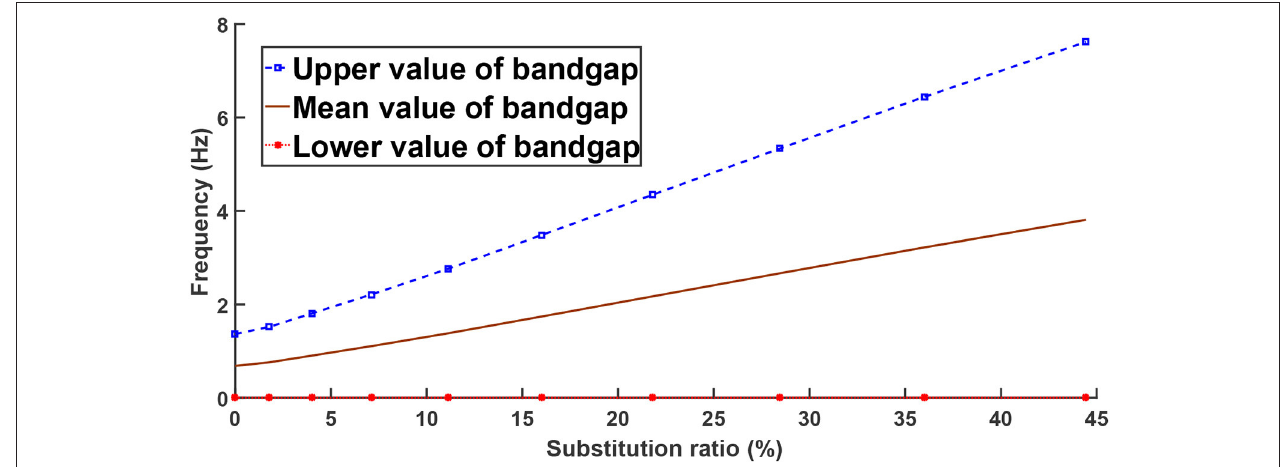
FIGURE 13 | Bandgap vs. substitution ratio plot for clamped configuration of square concrete inclusion in a unit cell of dimension 3 × 3 m. The soil properties are taken as E = 10 MPa, µ = 0.25, and ρ = 1,400 kg / m 3 .